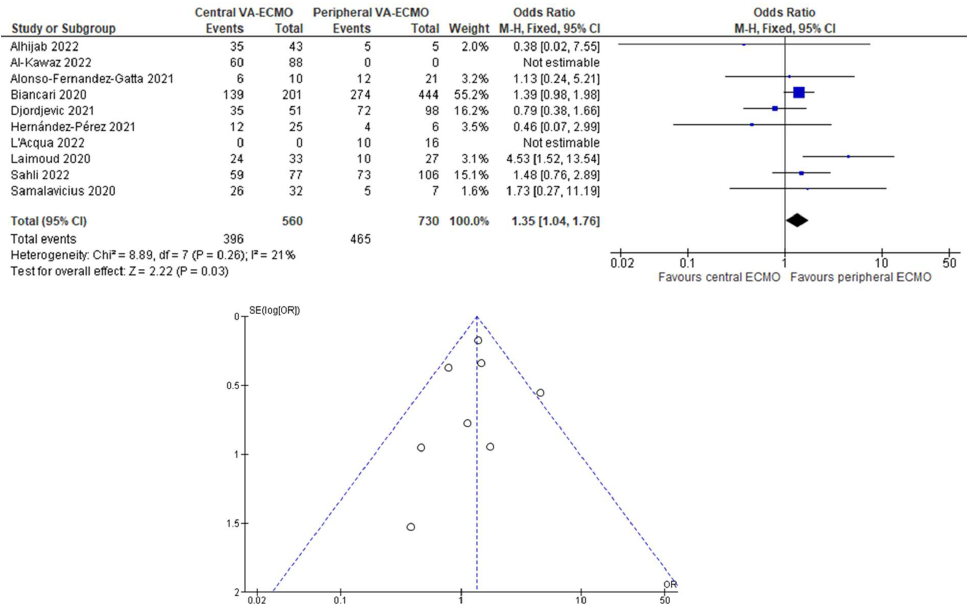
Figure 2. Forest plot and funnel plot from aggregate data meta-analysis [2,12–20].